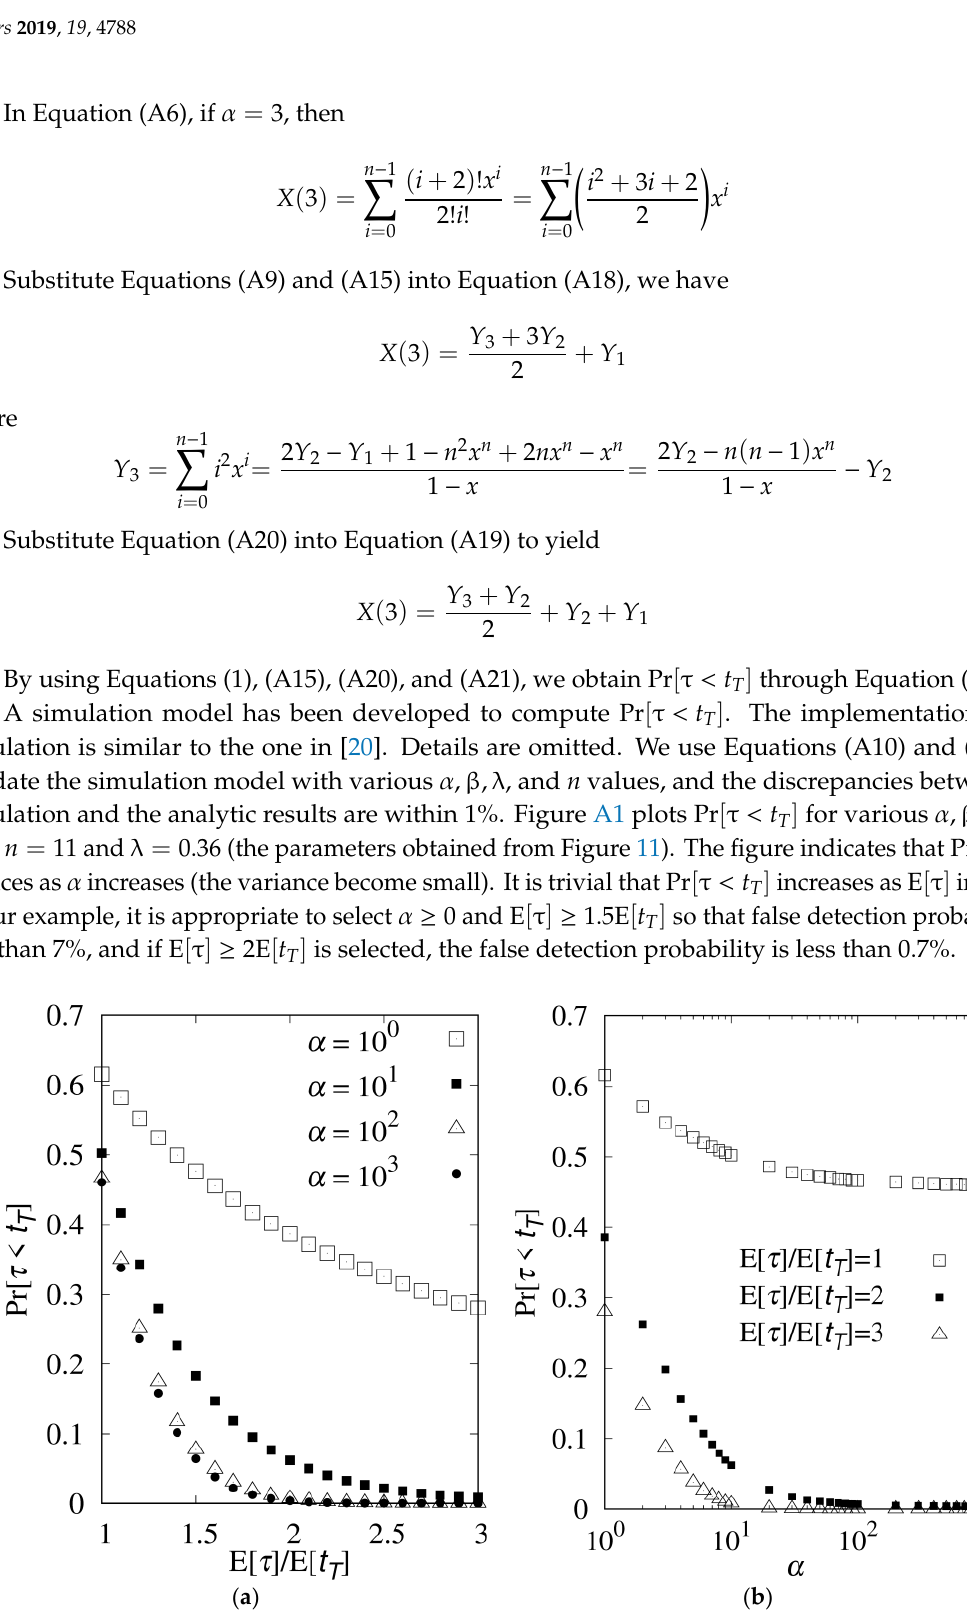
Figure A1. Pr[τ < t T ] against E[τ] and α. Figure A1. Pr [ τ < t T ] against E [ τ ] ( a ) and α ( b